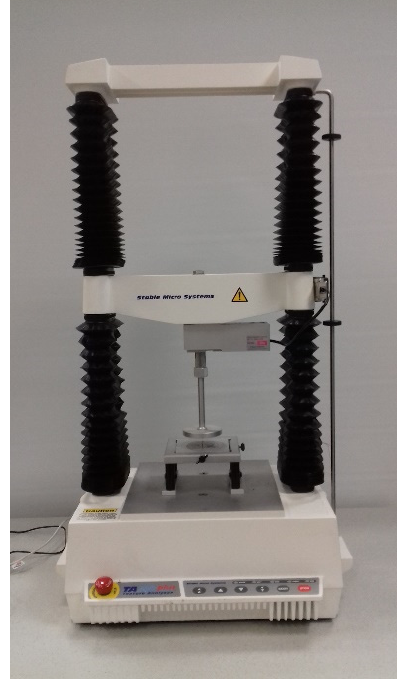
Figure 2. TA.HD plus texture analyser.